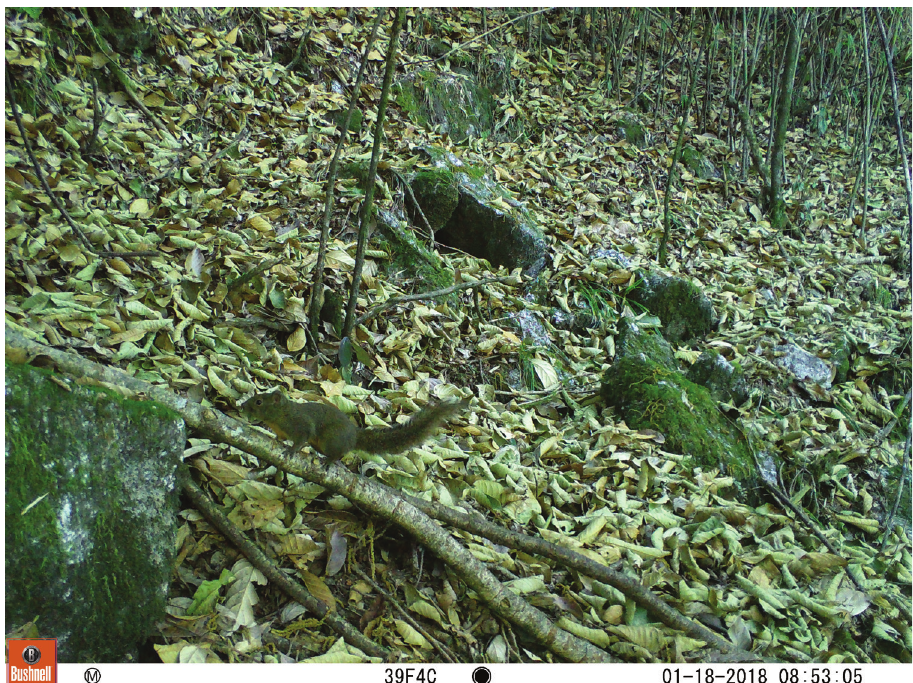
Figure 4. The Orange-bellied Himalayan squirrel Dremomys lokriah , a probable primary prey of marbled cat, is abundant in the study area. This individual was captured by the same camera trap (Sonam Tashi Lama-Lincoln University/Red Panda